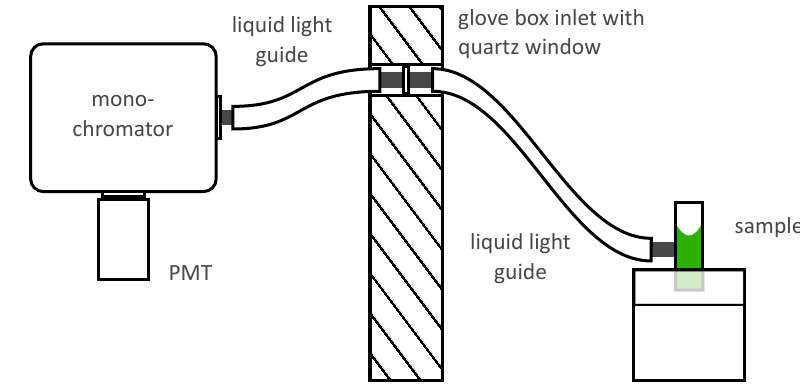
Figure 3. Schematic of the setup designed to measure the radioluminescence spectrum. A liquid or solid alpha active sample (green) resides on a holder inside holder in the glove box. A system of liquid light guides transports radioluminescent light to a monochromator, where it is spectrally separated and detected by a